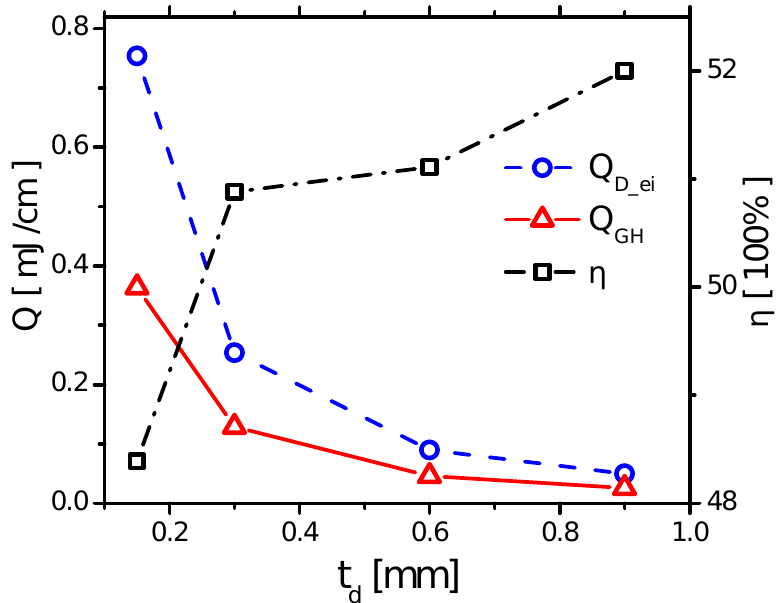
Figure 29. The effects of t d on the discharge energy Q D _ ei , the gas heating Q GH and its efficiency η GH in Case 1 and Cases